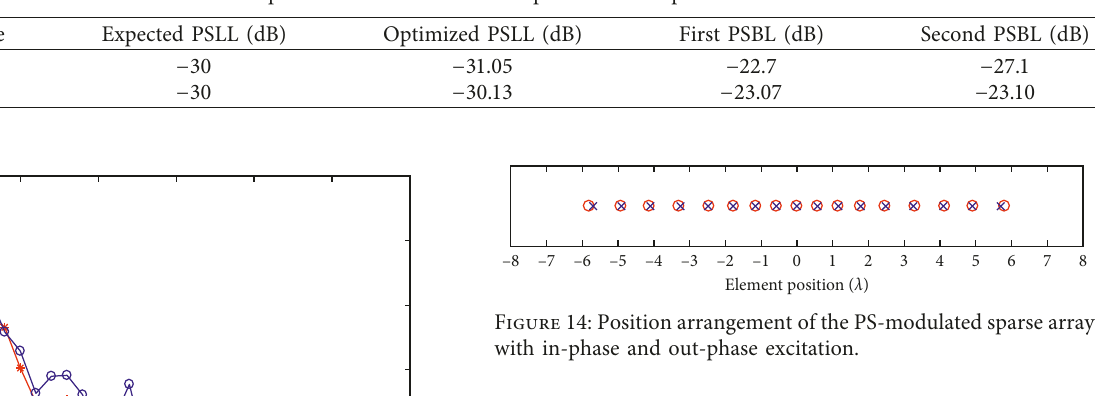
Table 5: Comparison of PSBL between in-phase and out-phase TMSLA.